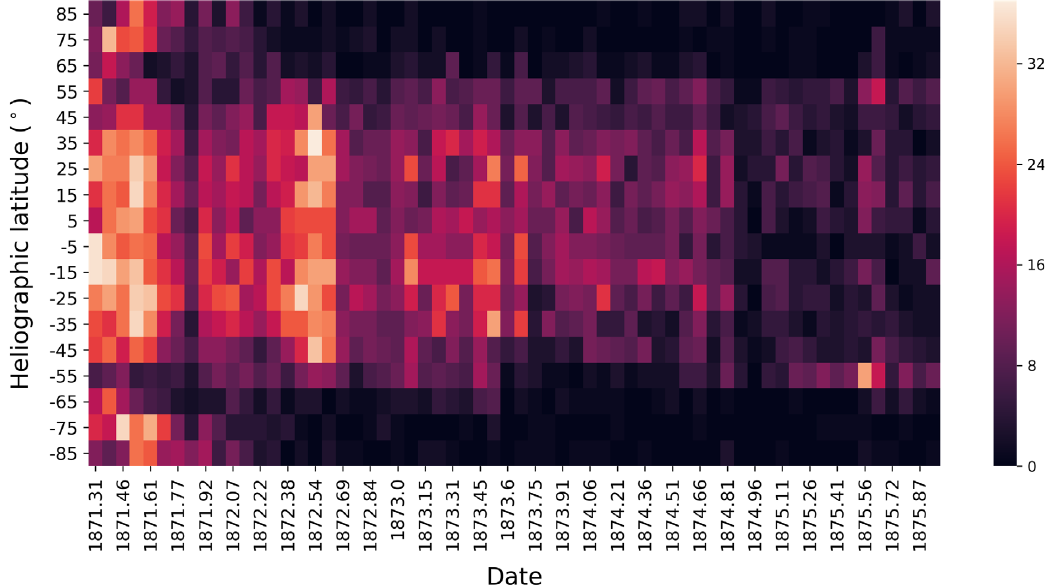
Fig. 5. Heliographic latitudes of prominences were recorded by Secchi (1875) for the period 1871 – 1875. Different colors represent the total number of prominences observed by latitude intervals in each solar rotation (dark colors mean less observed prominences and light colors the